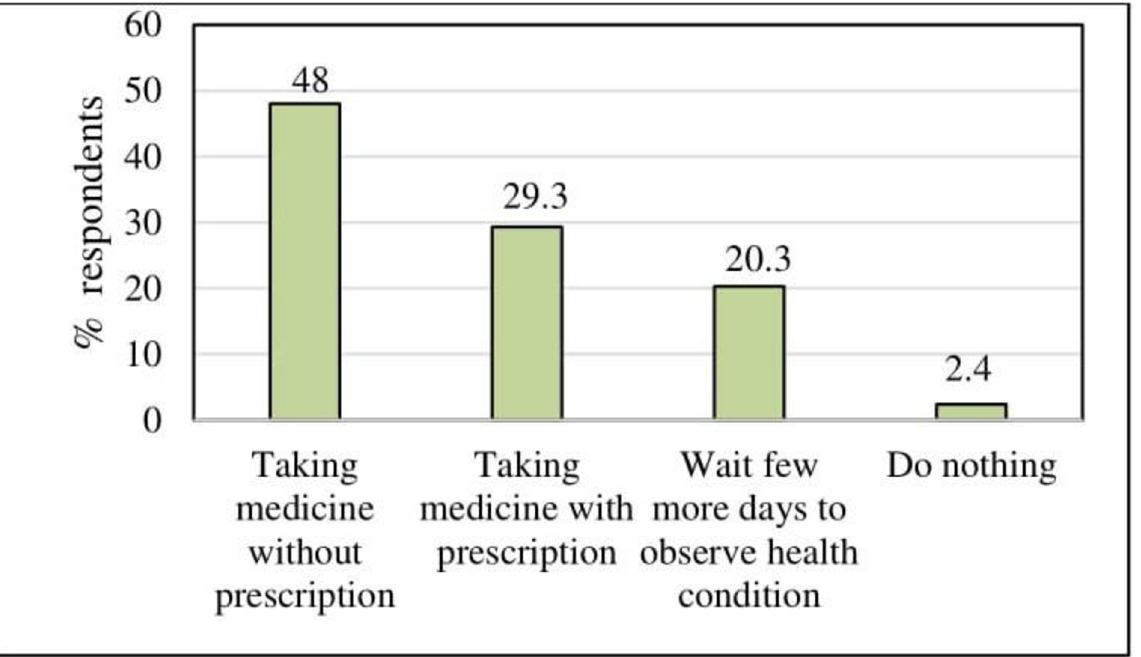
Fig 2. Steps after noticing any symptoms of